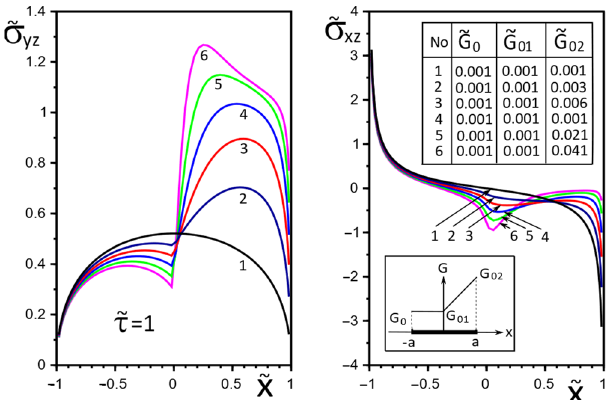
Figure 7. Stress distribution along with the upper interface (inclusion—matrix half ‐ space 2 S ) with a piecewise linear distribution of material stiffness.